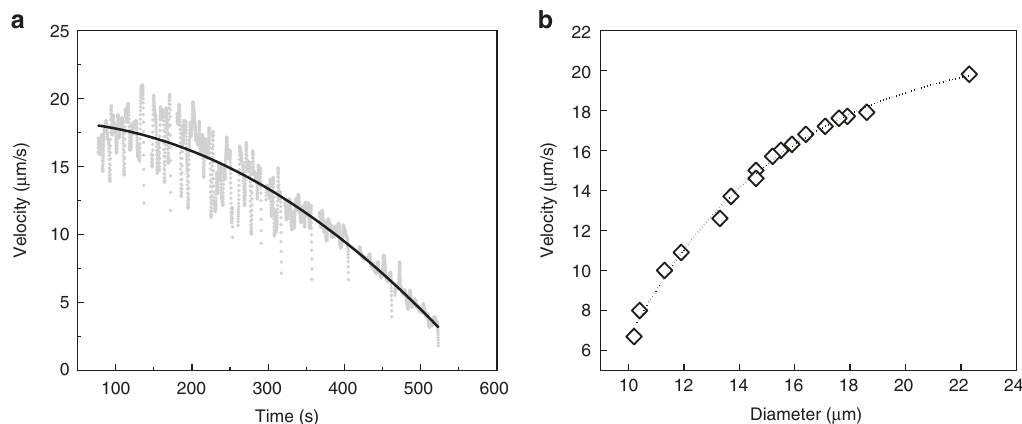
Fig. 3 Swimming velocity in time and against the size of the droplets. a The velocity of a chiral droplet doped with CB15 evolves in time. Here, the initial diameter of the droplet was ca. 19 μ m (data shown for one individual droplet). b Velocity of motile droplets as a function of their diameter. These data correspond to a collection of drops, and was acquired during their